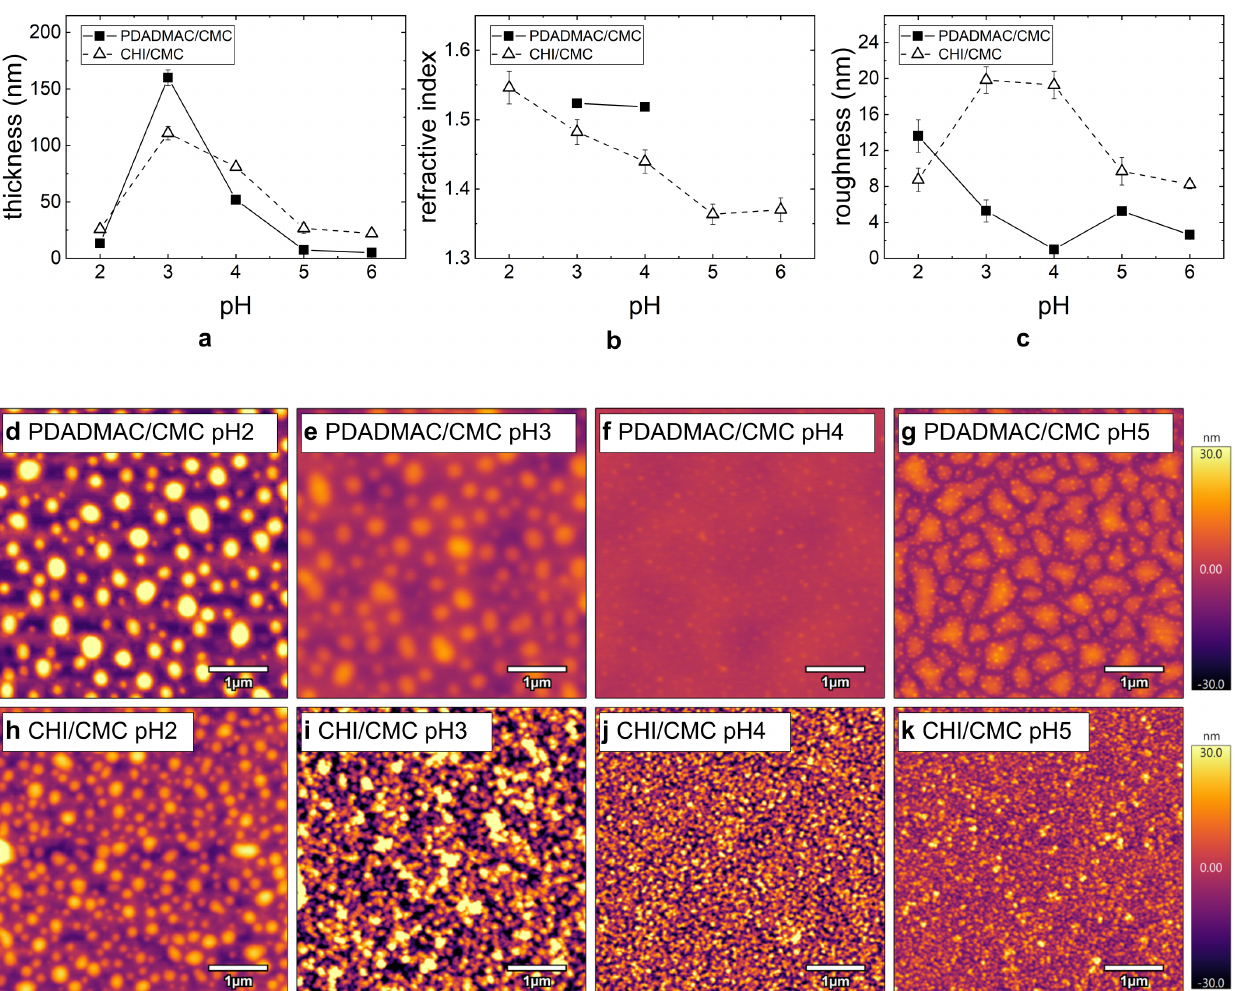
Figure 4. Summary of the morphology results for PEMS PDADMAC/CMC (filled squares) and CHI/CMC (empty triangles) from ellipsometry ( a , b ) and AFM measurements ( c – k ): ( a ) Film thickness, ( b ) refractive index, and ( c ) roughness with varying pH-values. ( d – k ) AFM images (5 × 5 µm 2 ) for PDADMAC/CMC and CHI/CMC at pH = 2, 3, 4, and 5. For all images, the height scale is set to 60nm. The samples were prepared at c PE = 1g/L and seven BL. All experiments were carried out at RH ≈